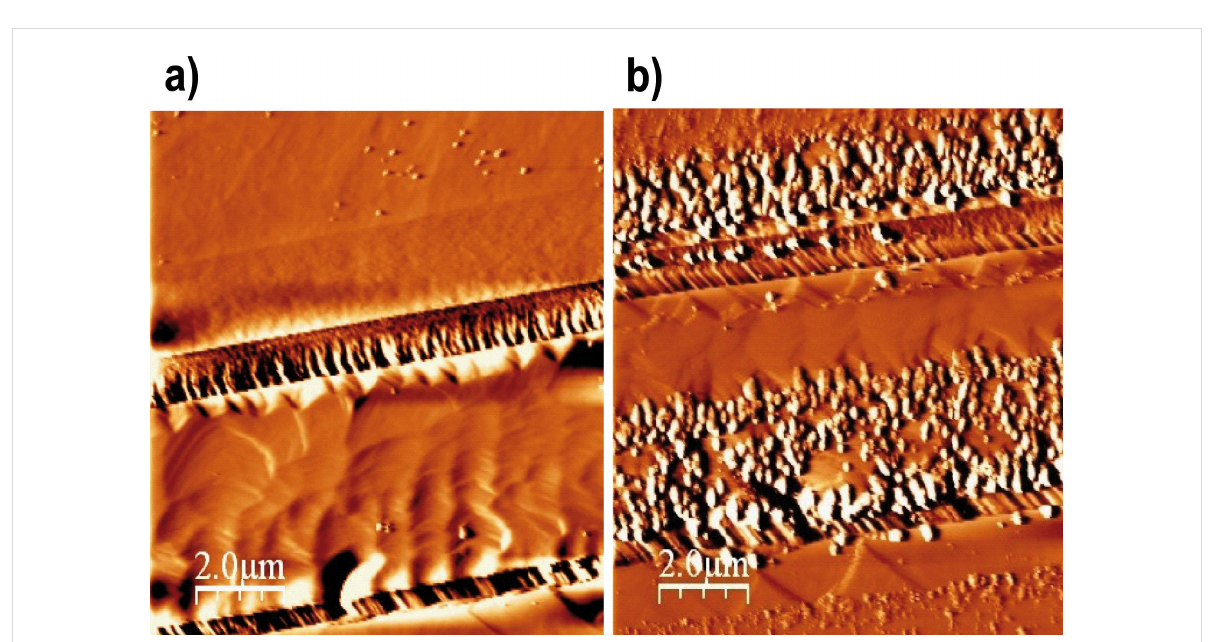
Figure 8: Sequential AFM deflection images of reacted dolomite surface in pH 3 (H 2 SO 4 ) in solution equilibrated with respect to gypsum: a) after 4 h, shallow and deep etch pits are visible on the dolomite surface and b) after 6 h, gypsum precipitated mainly along the step edges.